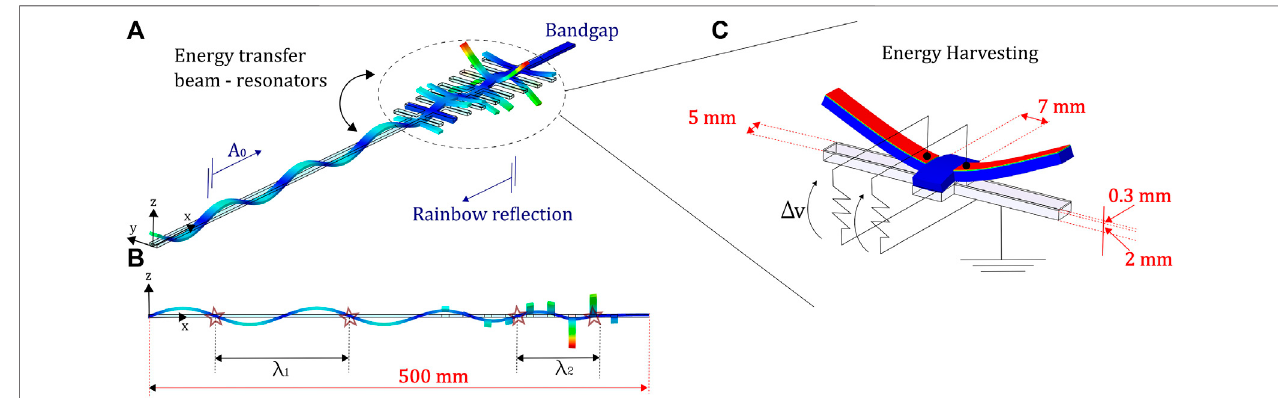
FIGURE 1 | Schematic of the graded linear array of fl exural resonators for energy harvesting. (A) By exciting the elastic beam with an A 0 fl exural wave, energy is ef fi ciently transferred to the array of resonators. Such interaction reduces both the amplitude and the wavelength of the waves in the beam inside the array (B) . Leveraging on this energy transfer mechanism, the elastic energy in the resonators can be used for piezoelectric energy harvesting (C) .